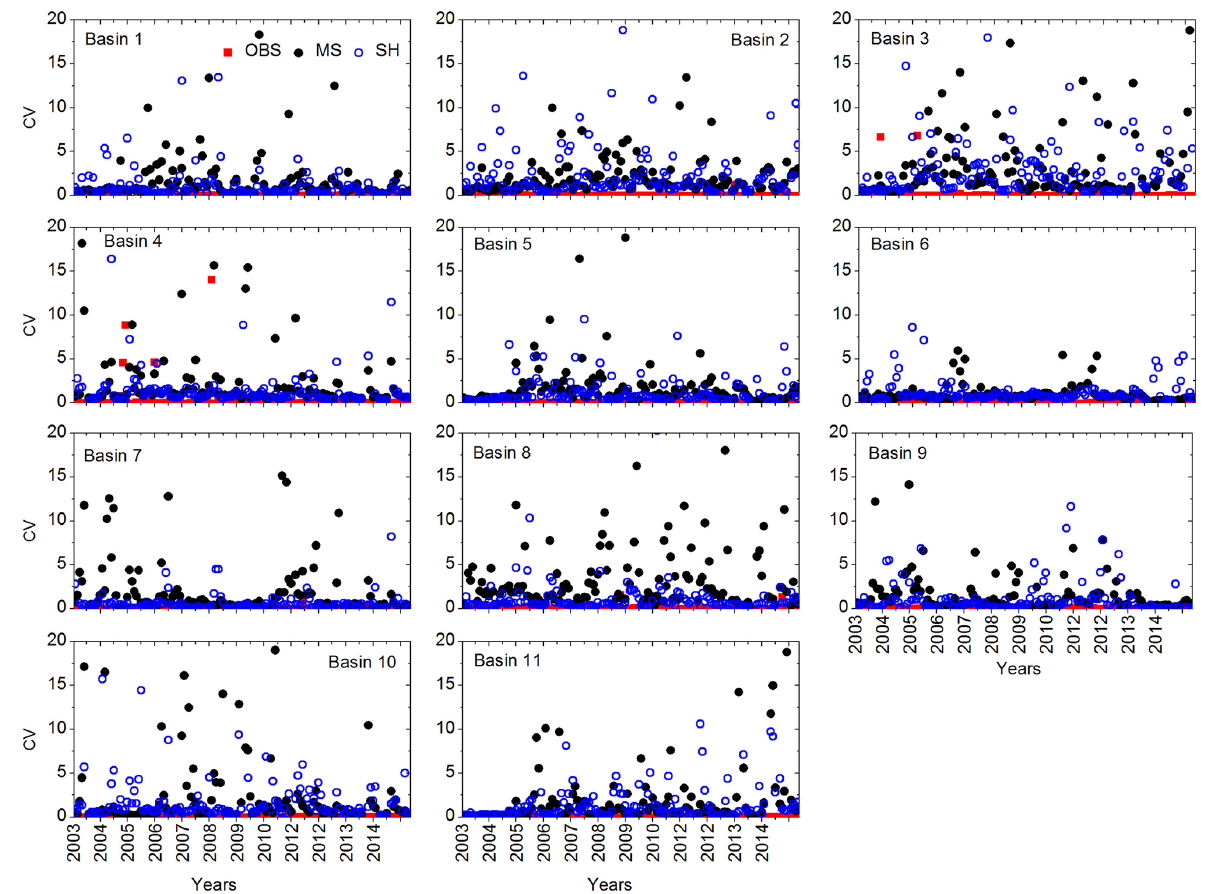
Figure 5. Basin-wide coefficient of variation (CV) analysis for in situ GWSA (OBS, red squares) and GWSA obtained using the GRACE mascon product (MS, black filled circles) and GRACE SH products (SH, blue open